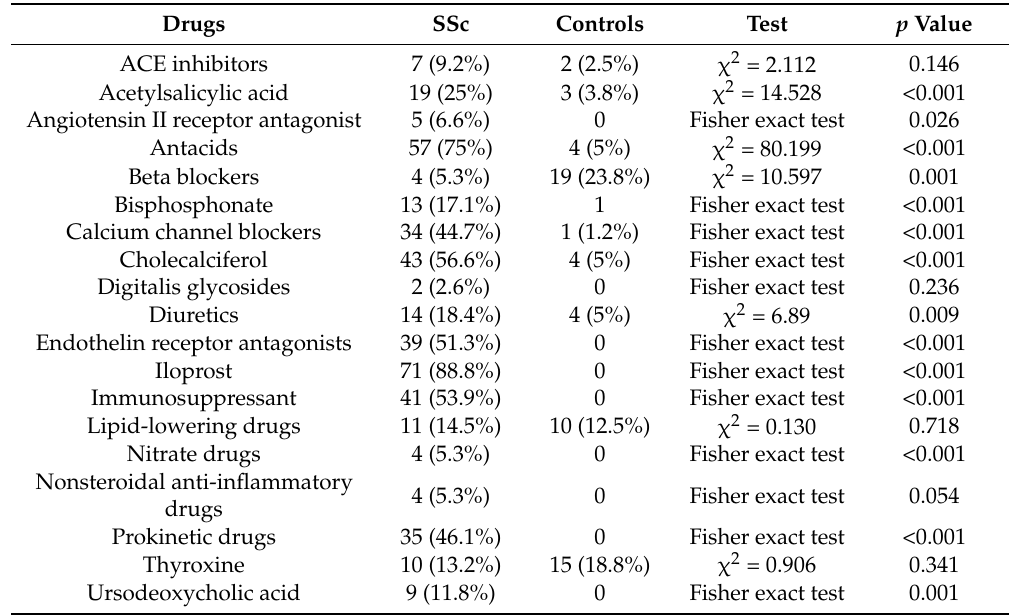
Table 4. SSc patients and controls’ drugs.